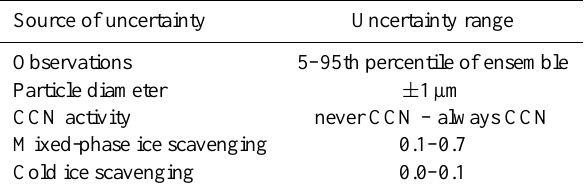
Table 3. Uncertainty ranges used for calculation of model uncer- tainty, observation uncertainty, and normalized model